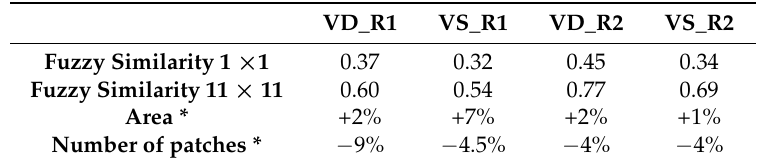
Table 4. Fuzzy similarity index for a window size of 1 × 1 and 11 × 11 cells, relative change in area and number of patches.